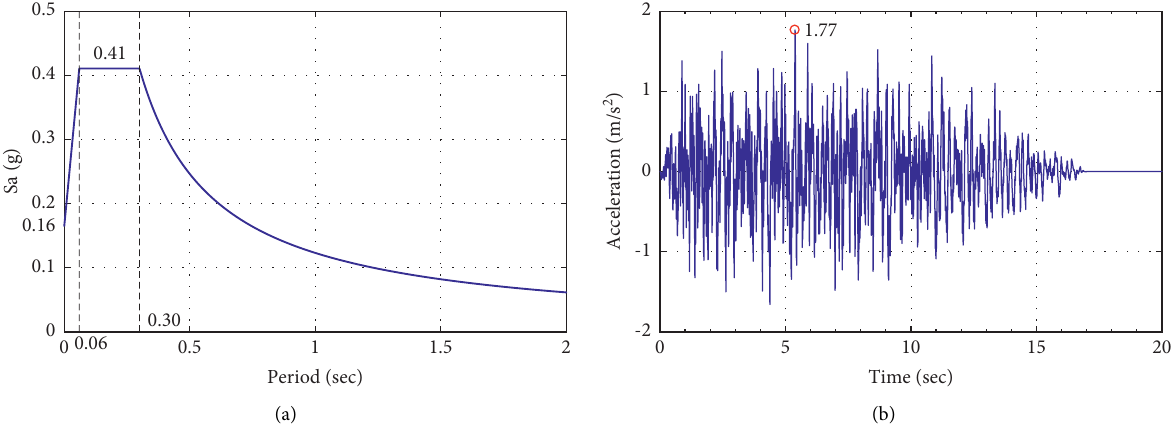
Figure 10: Design response spectrum (DRS) and a time history data of artificial earthquakes used for the parametric study. (a) Design response spectrum (DRS). (b) A time history data from the DRS.